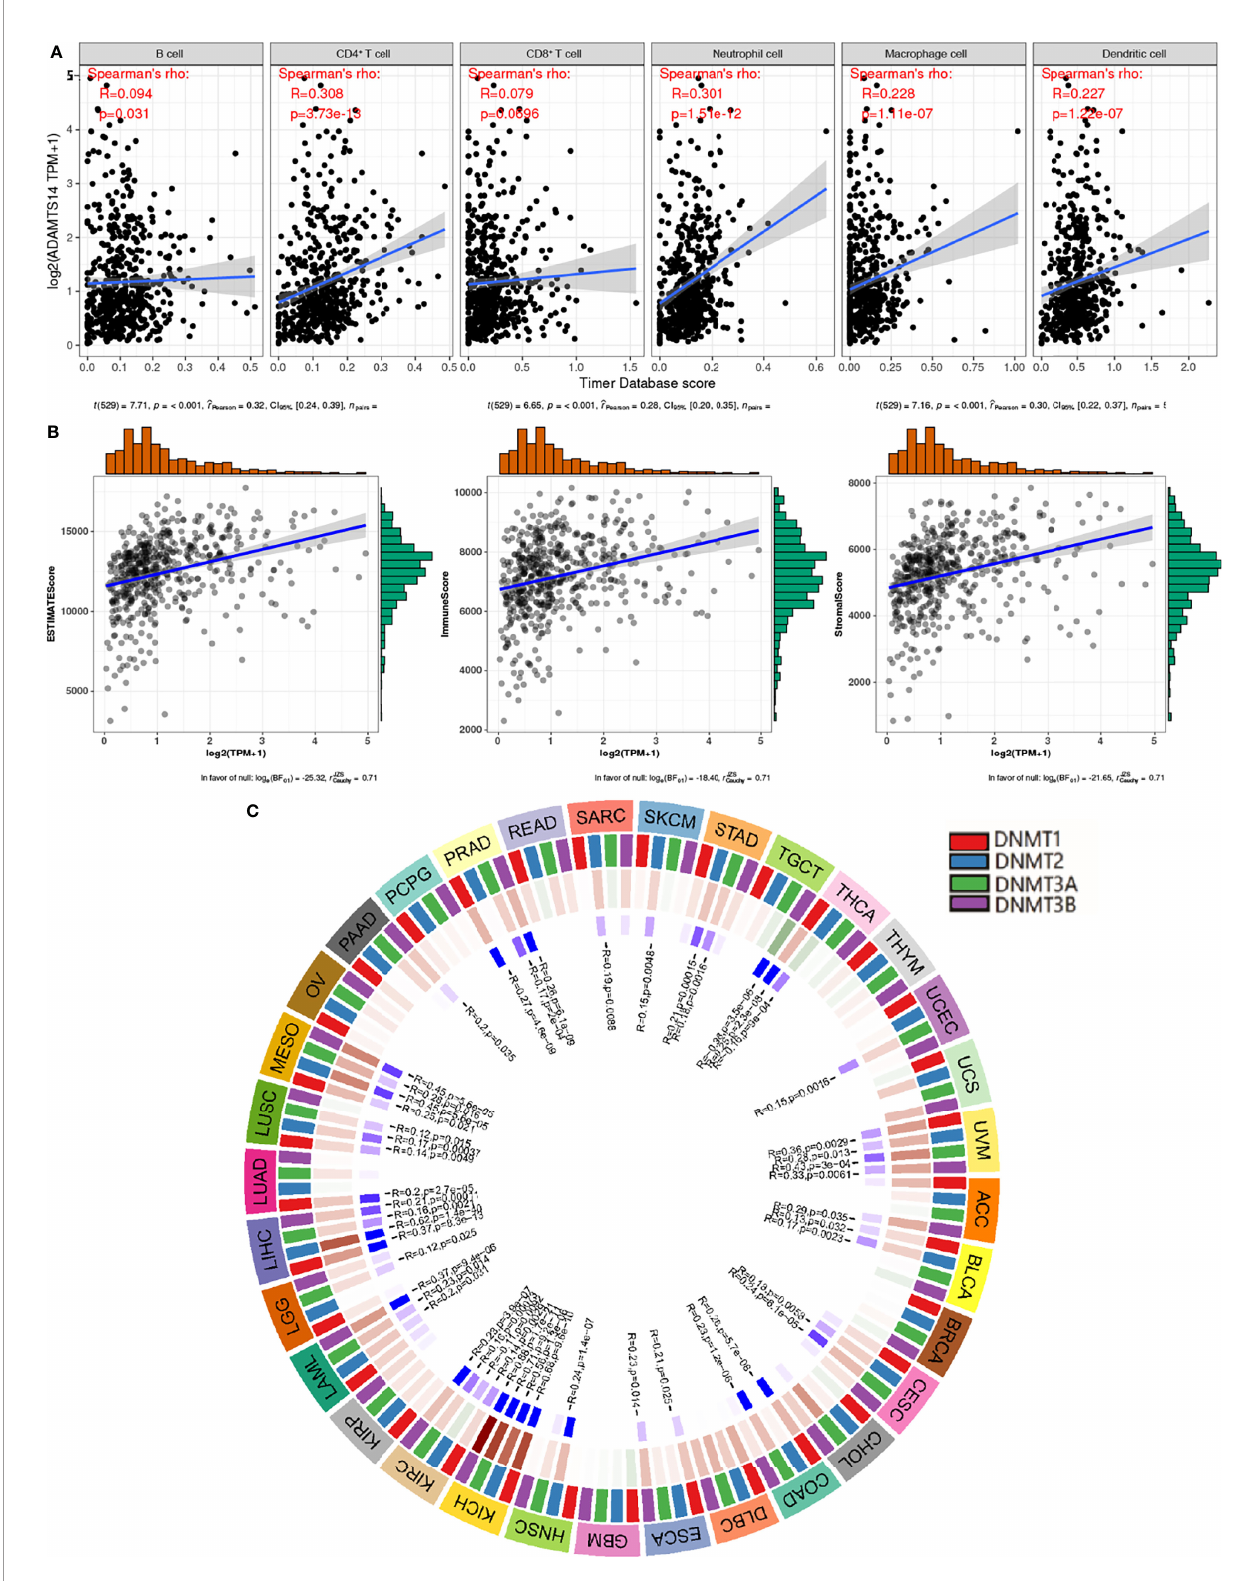
FIGURE 7 | Associations between ADAMTS14 and (A) immune in fi ltrations, (B) tumor microenvironment, and (C) methyltransferase in TCGA